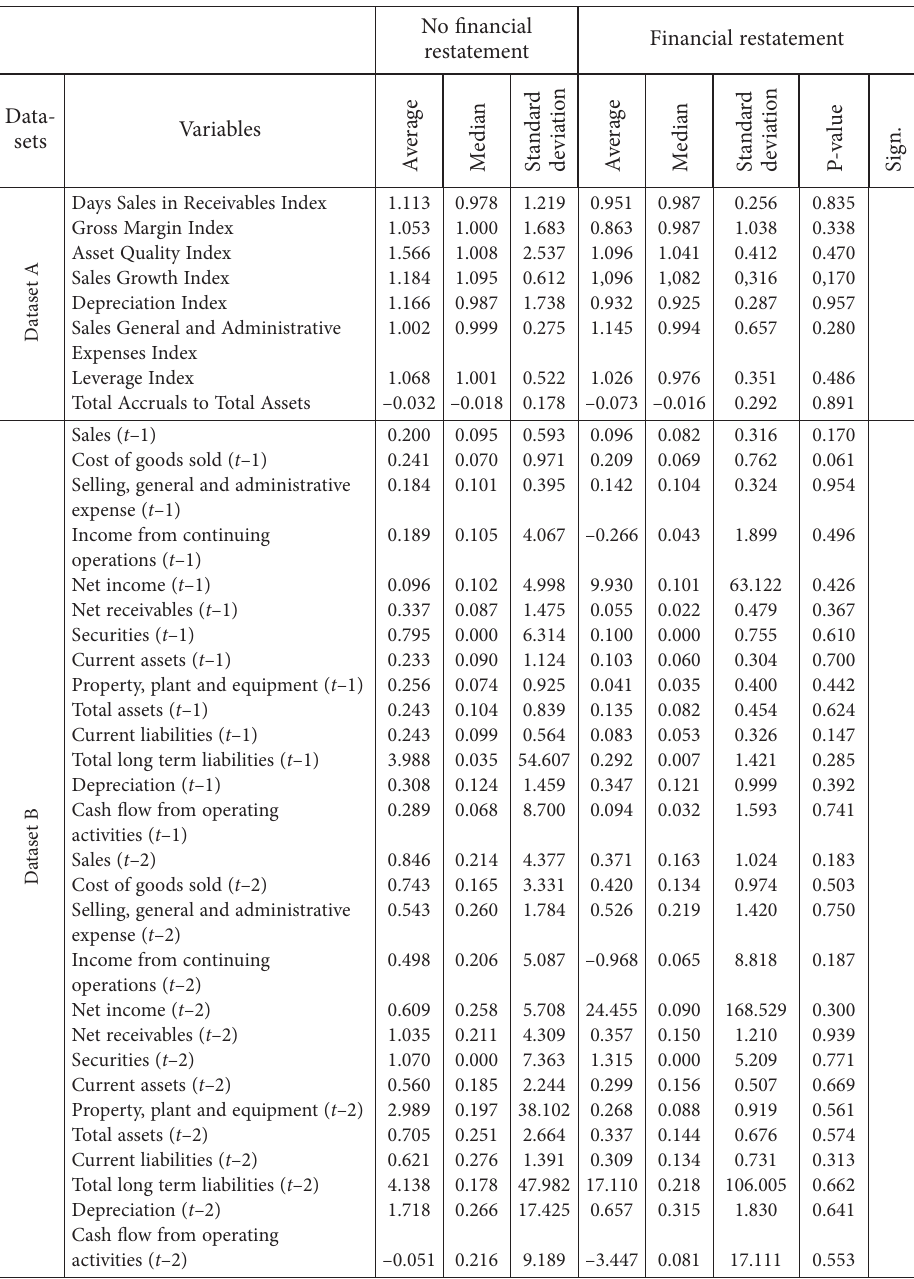
Table 3. Descriptive analysis for tested variables